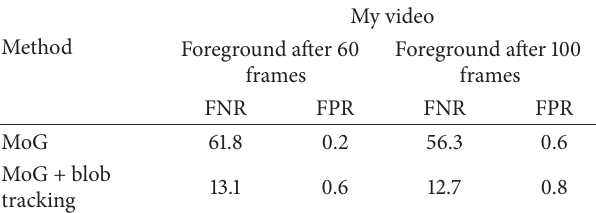
Table 1: FNRs and FPRs